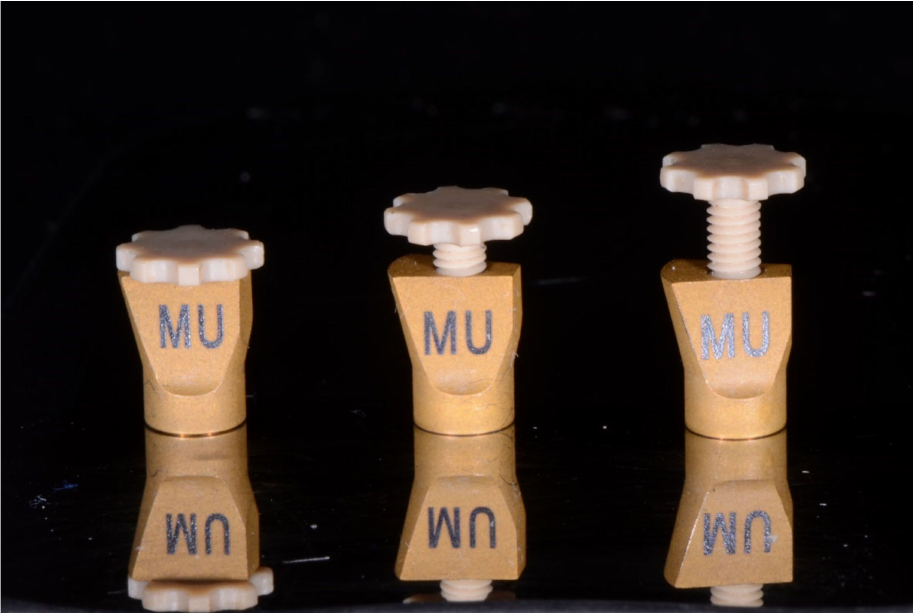
Figure 8. Dual-function scan bodies on multi-unit abutment level (MU). The screw channel of the scan body contains a screw-thread to attach the bite pillar and to adjust it to the correct vertical height.